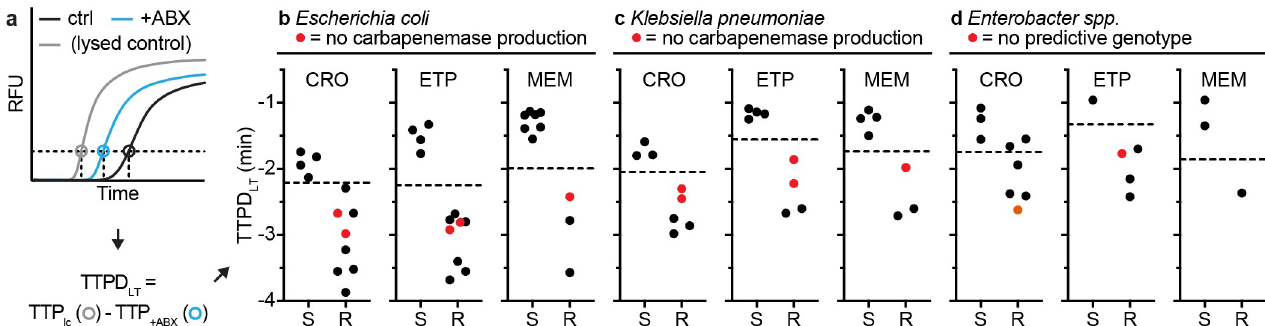
Fig 5. Validation of the pol-aAST method using lysed control and antibiotic-treated aliquots. (a) Example calculation of TTPD between the lysed control and antibiotic-treated aliquots (TTPD LT ). The TTP (in minutes) in the lysed control and antibiotic-treated aliquots are used to calculate TTPD LT . (b–d) The pol-aAST results using E . coli (b), K . pneumoniae (c), and Enterobacter spp. (d) isolates exposed to CRO, ETP, and MEM for 15 min. Red points represent isolates with either no detectable carbapenemase genes ( Ec and Kp isolates) according to a published genotypic assay [67] and commercial assay [68], or no predictive genotype ( Ebs isolates) according to the CDC [66]. S/R thresholds (dashed lines) were set halfway between the lowest susceptible and the highest resistant TTPD LT values except in the case of Enterobacter spp. treated with CRO (see text). Raw data are provided in S3 Table. +ABX, antibiotic-treated; AST, antibiotic susceptibility testing; CDC, Centers for Disease Control and Prevention; ctrl, control; CRO, ceftriaxone; Ebs , E . aerogenes and E . cloacae collectively; Ec , E . coli ; ETP, ertapenem; Kp , K . pneumoniae ; lc, lysed control; MEM, meropenem; pol-aAST, polymerase-accessibility AST; R, resistant; RFU, relative fluorescent units; S, susceptible; TTP, time-to-positive; TTPD, time-to-positive difference; TTPD LT , TTPD lysed-control to treated.